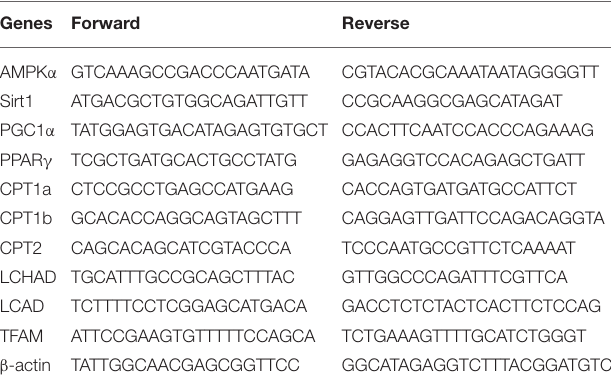
TABLE 1 | Primer sequences of study